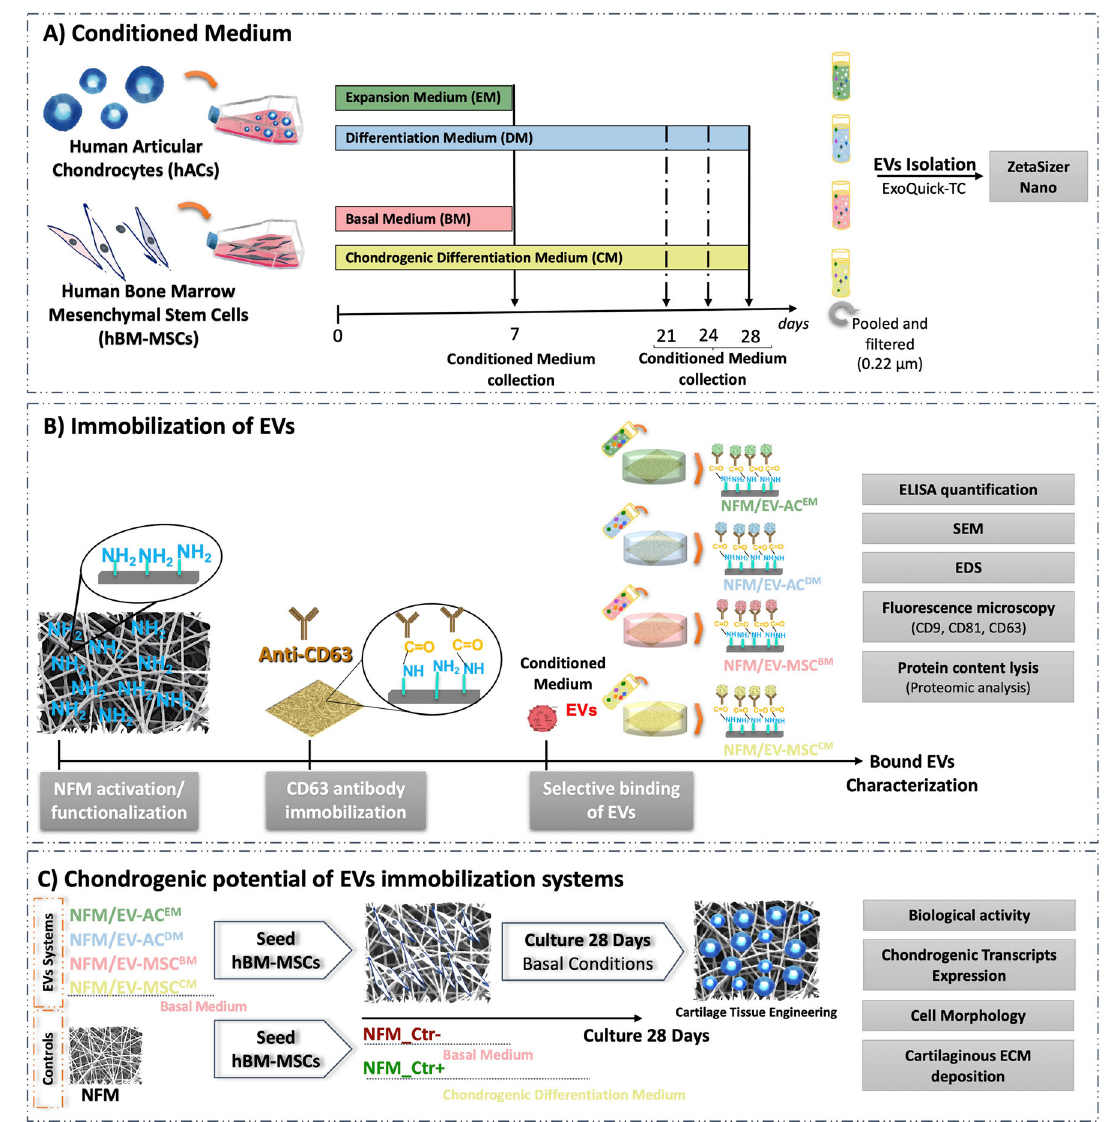
Fig. 7 Schematic illustration of the experimental design. Conditioned media preparation ( A ); development of EV immobilization systems and characterization of bound EVs ( B ); assessment of the chondrogenic potential of EV immobilization systems ( C